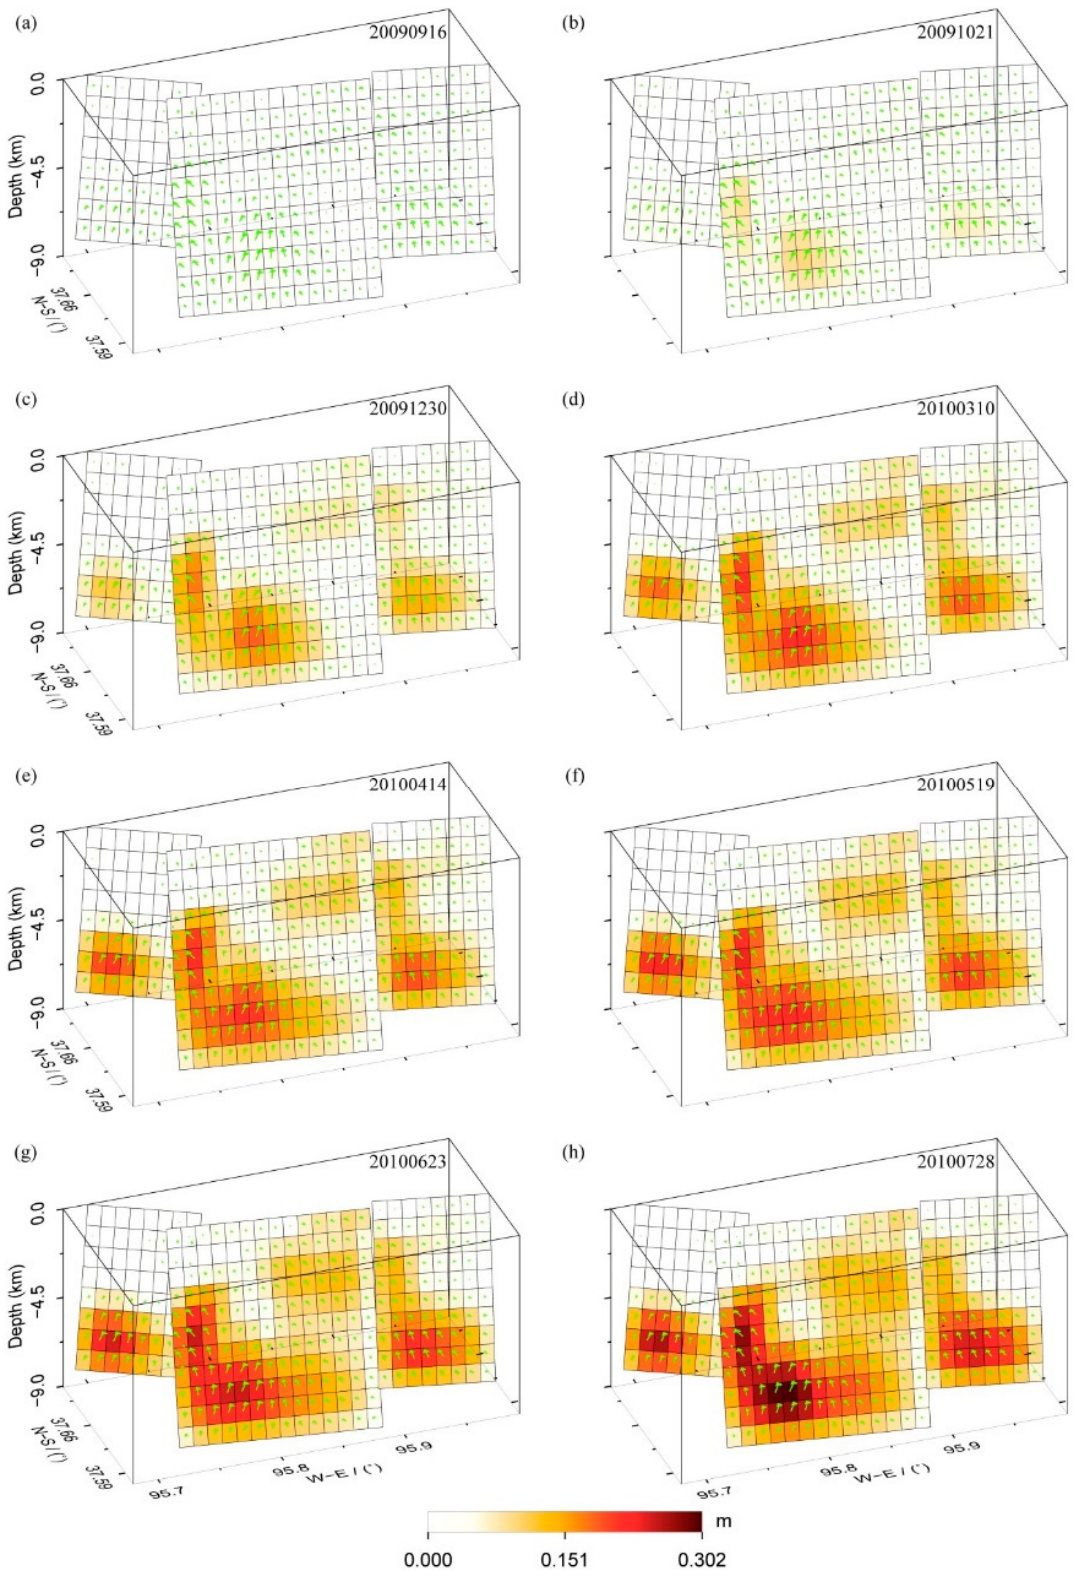
Figure 6. ( a – h ) Temporal and spatial distribution of postseismic afterslip, corresponding successively to the eight time epochs of InSAR observations. The characters labeled in all subfigures are the corresponding observation dates. Green arrows in all subfigures indicate the slip direction on the corresponding fault patch.